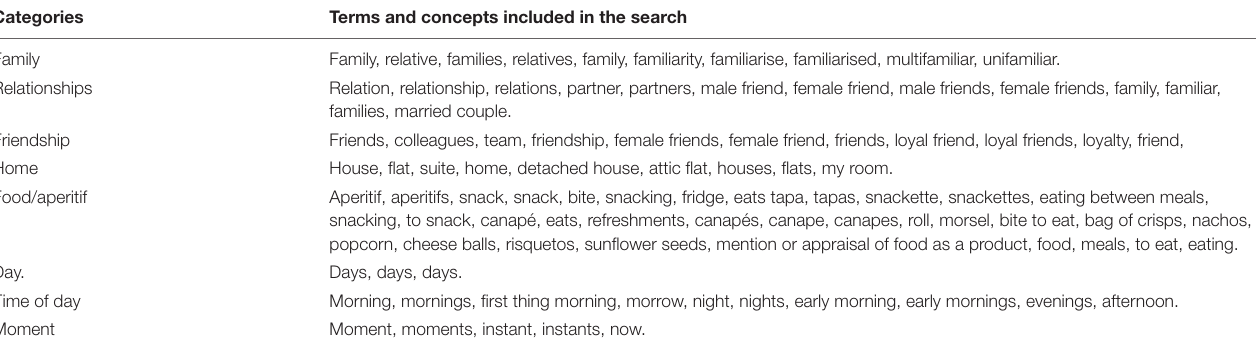
TABLE 6 | Analysis categories related to close context. Terms and concepts included in the